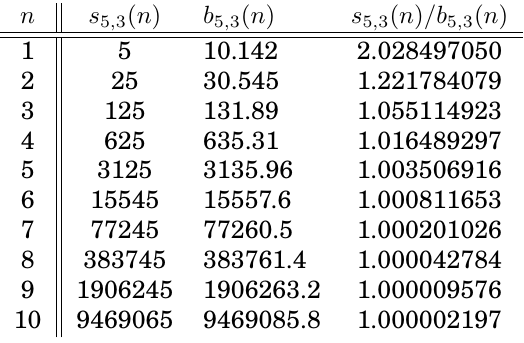
Table 2: Some numerical values of the sequences s 5 , 3 ( n ) and b 5 , 3 ( n ) . The r -rough